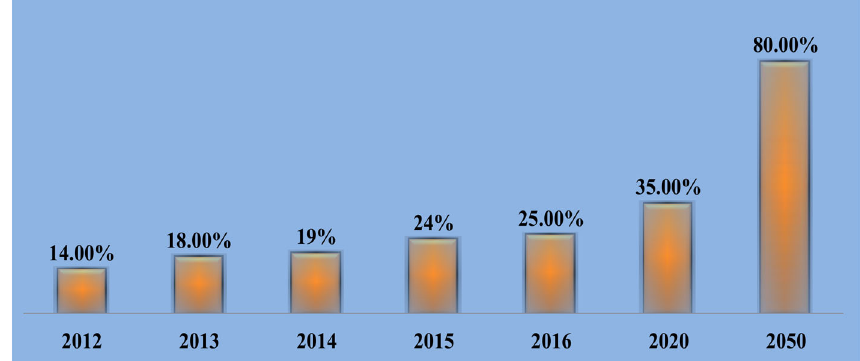
Fig. 2 Increasing Rate of Energy Generation from Renewable Energy Sources in Present and Future [8,